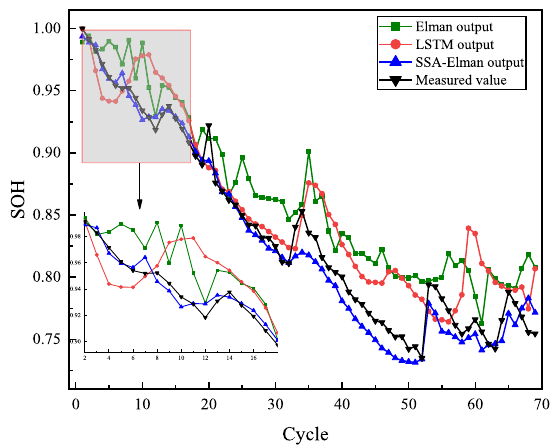
Fig. 16 Estimated results for battery B0029